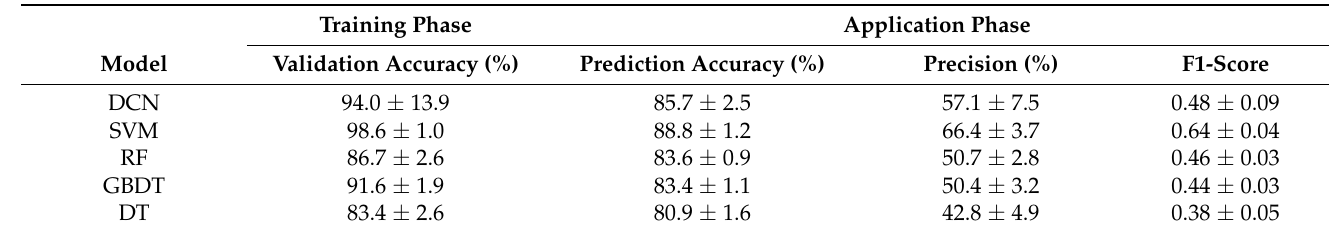
Table 5. Predictive results of conventional models: mean and standard deviation of validation accuracy, prediction accuracy, precision, and F1-score from 100 runs.